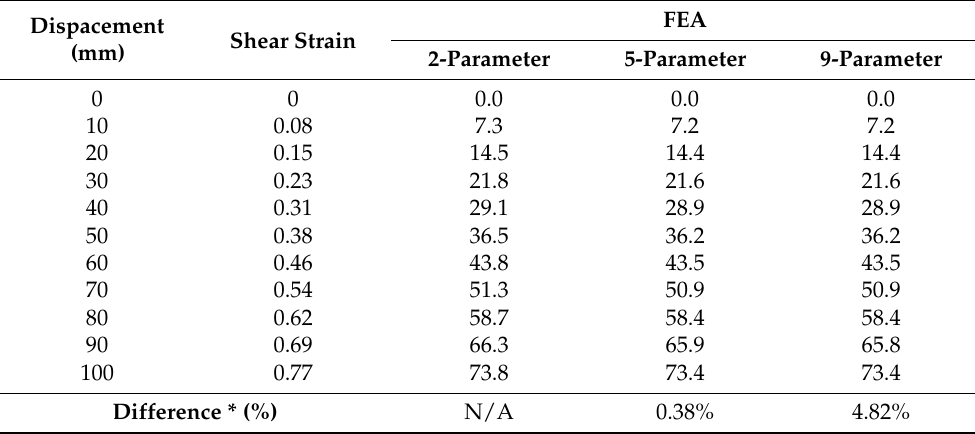
Figure 12. Shear force-displacement graph with respect to the three M-R models through the nu- merical simulation.